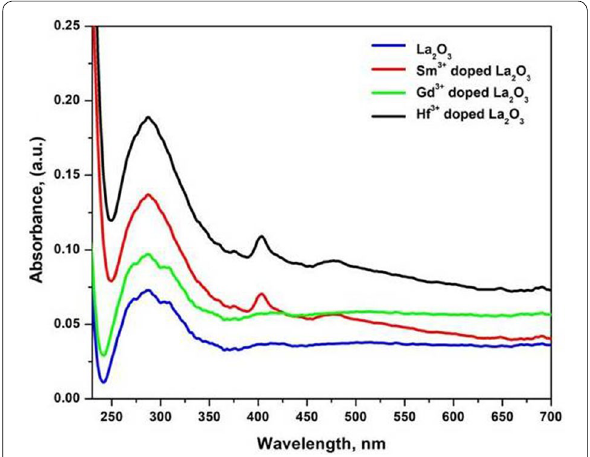
Fig. 1 Room temperature optical absorption spectrum of undoped and doped